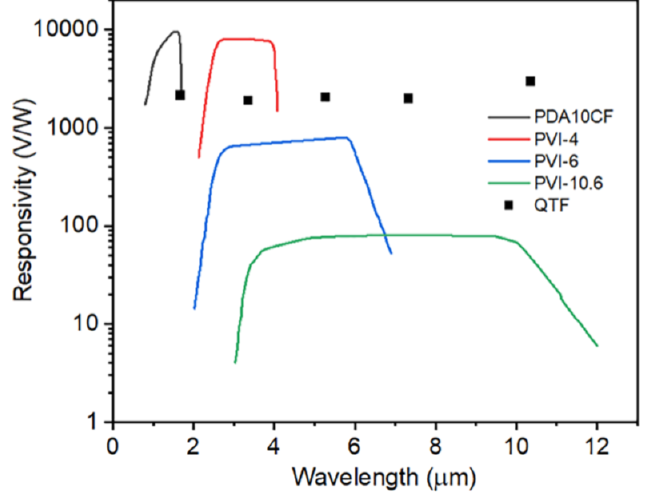
Figure 12. Solid lines: responsivity as a function of the wavelength for three models of photovoltaic Vigo detectors, namely PVI-4 (red line), PVI-6 (blue line), and PVI-10.6 (green line) HgCdTe, and for Thorlabs PDA10CF InGaAs Amplified Photodetector (black line), as provided by the device manufacturers. Black square: responsivity as a function of the wavelength for the used custom QTF. Reprinted/adapted with permission from Ref. [70]. Copyright 2021, copyright AIP Publishing.